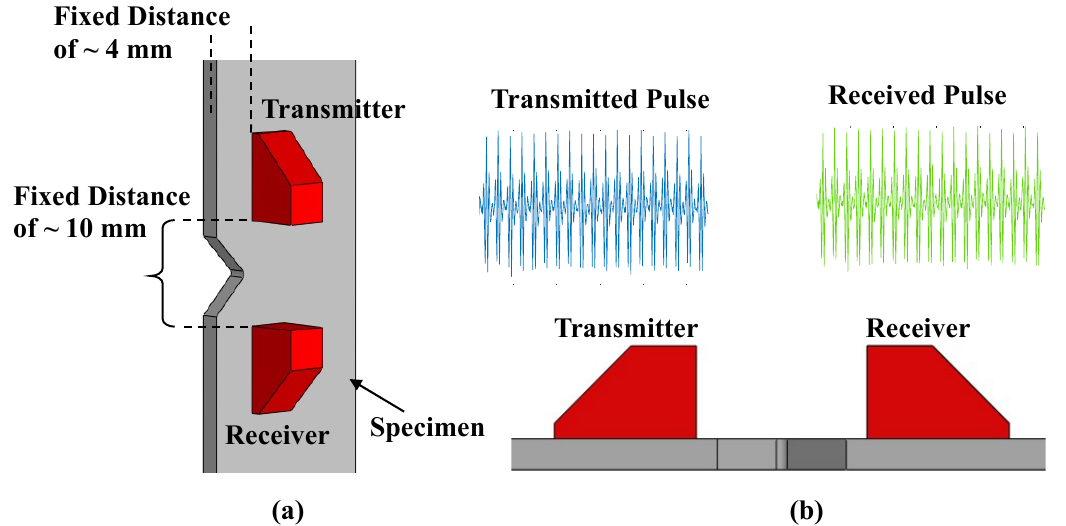
Figure 4. ( a ) A schematic (not to scale) showing the placement of the ultrasonic sensors on the specimens; ( b ) An alternate view of the specimens and the sensors. Representative transmitted and received signals are also illustrated.